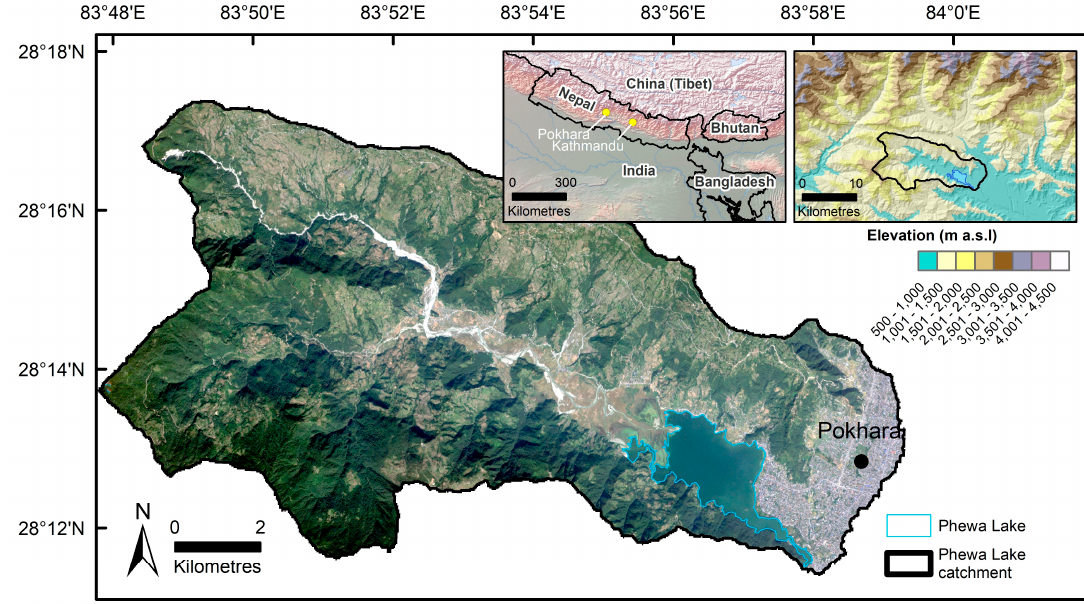
Figure 1. Phewa Lake catchment and the city of Pokhara located in central Nepal. True-colour RapidEye background (10 November 2017).